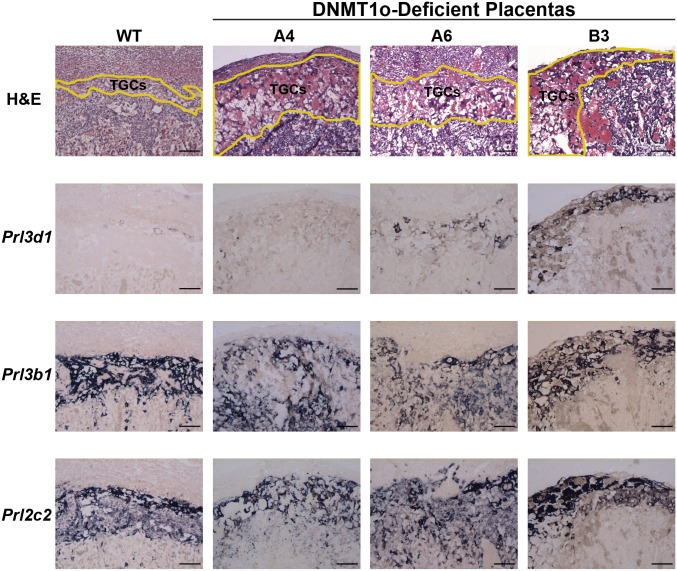
In situ hybridization analysis of TGCs in E12.5 wild-type and DNMT1o-deficient placentas with low Kcnq1 gDMD methylation.All images were taken at 100X magnification. The scale bar is 100μm. Yellow lines delineate the layer containing trophoblast giant cells (TGCs) in the top row displays histology of hematoxylin and eosin (H&E) stained sections. ISH for the prolactin gene family members Prl3d1, Prl3b1 and Prl2c2 on adjacent sections to H&E are shown in the lower three rows.